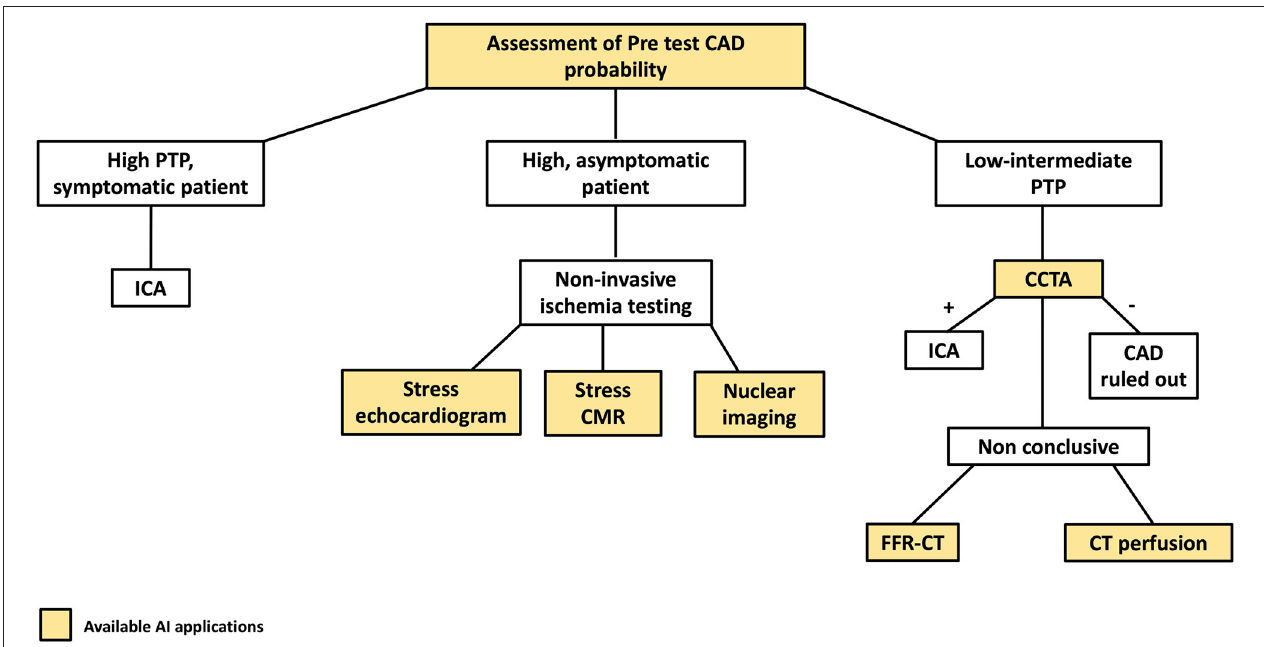
FIGURE 1 | AI applications to the coronary artery disease (CAD) clinical workflow. The figure describes the stages of the clinical CAD workflow in which AI have found applications. PTP, pre-test probability; CCTA, coronary computed tomography angiography; ICA, invasive coronary